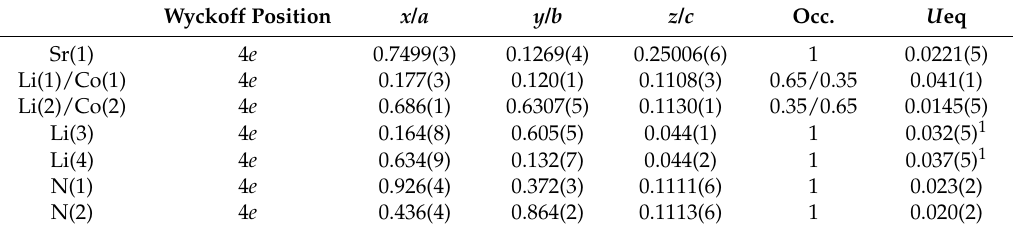
Table 2. Atomic positions, occupations and isotropic displacement parameters (Å 2 ) for the refinement